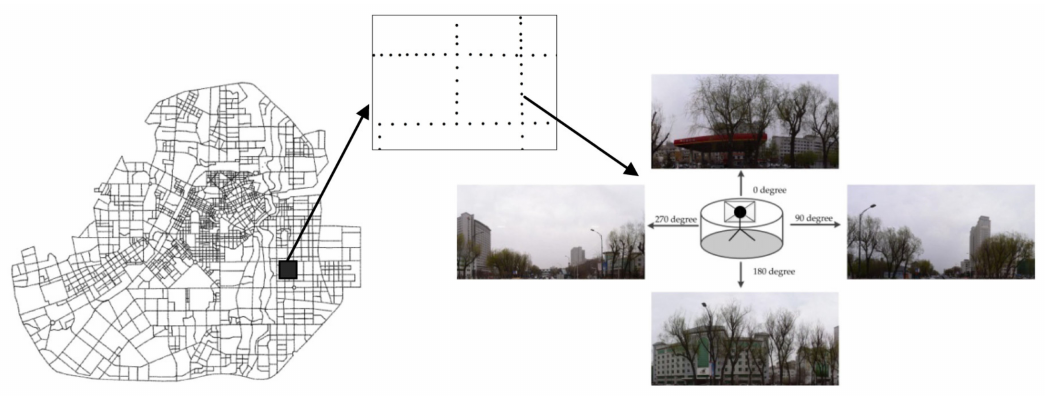
Figure 3. Schematic diagram of the street view